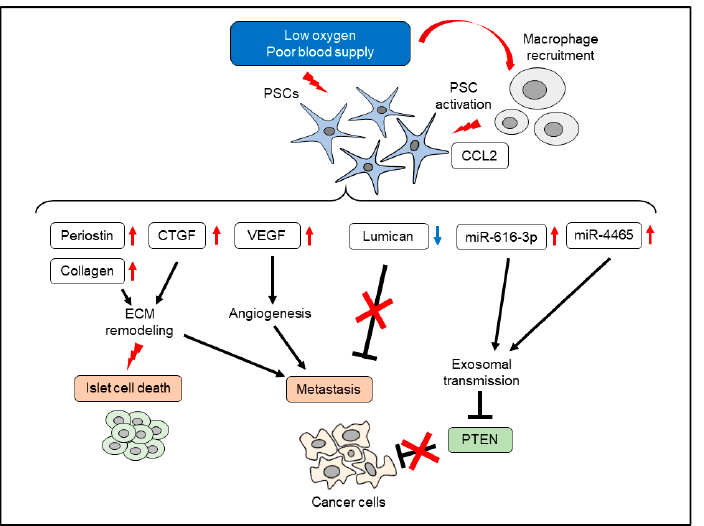
Figure 2. Effects of hypoxia in PSCs. CCL2, chemical chemokines 2; CTGF, connective tissue growth factor; VEGF, vascular endothelial growth factor.